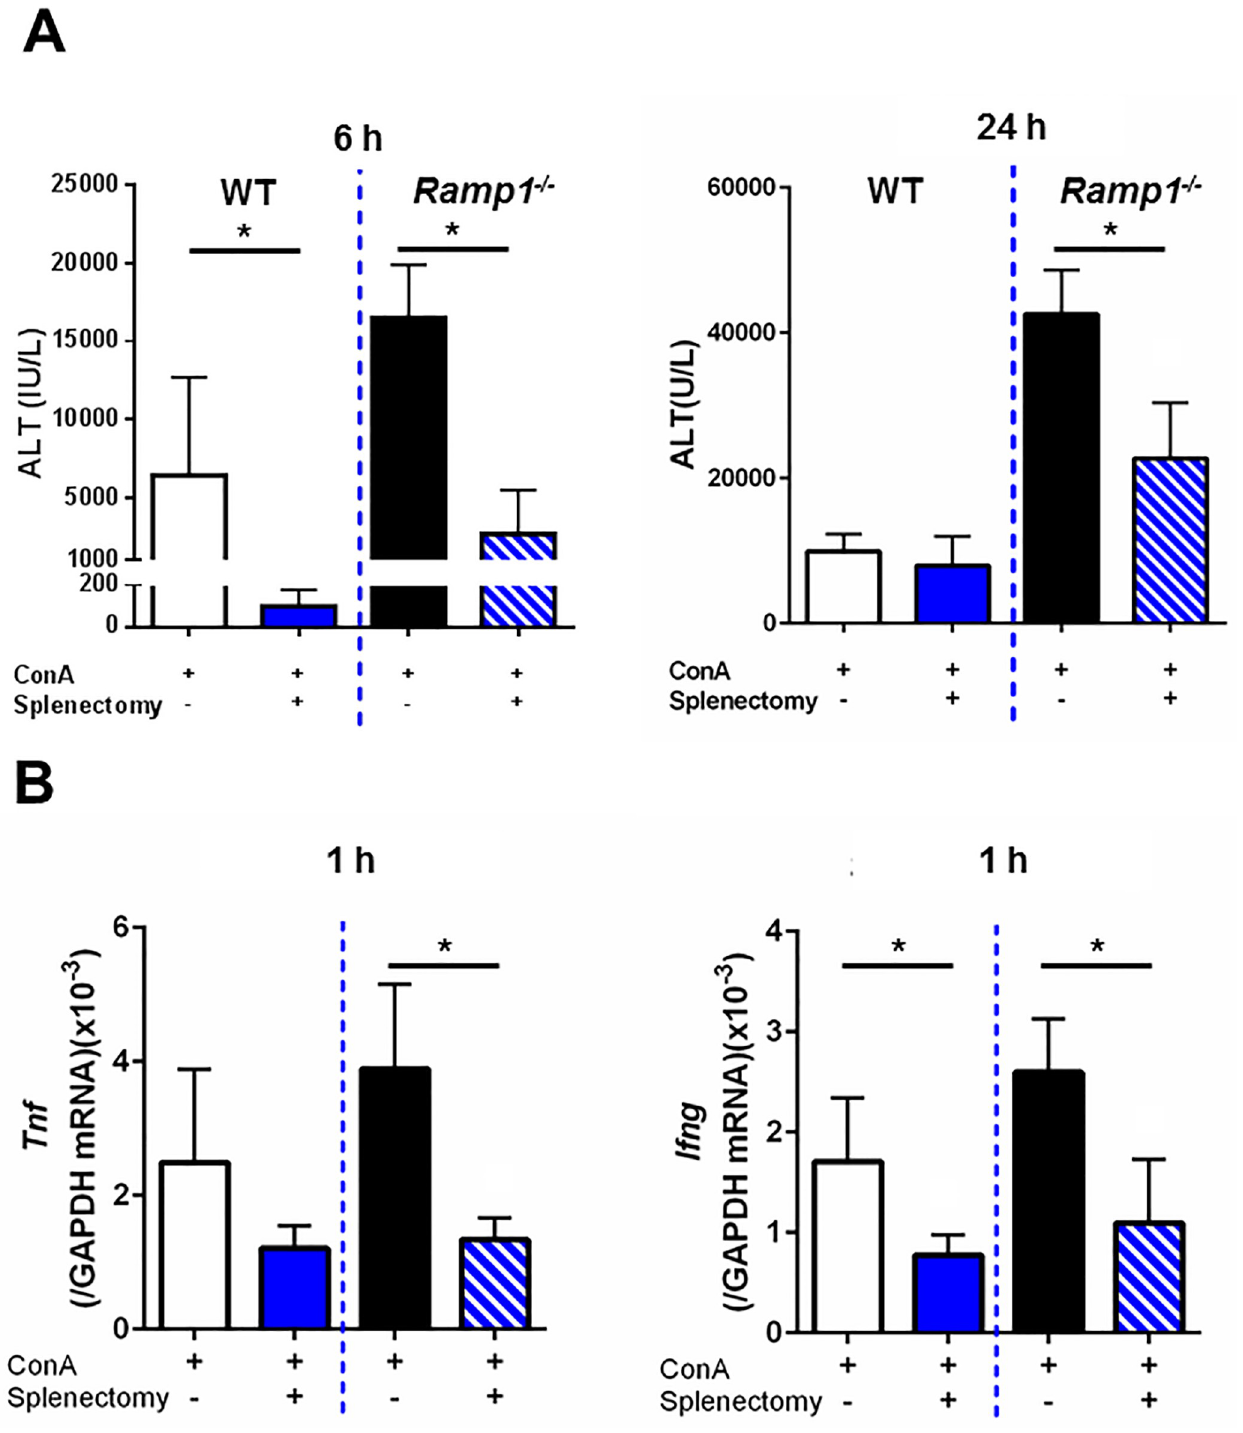
Fig 3. Effects of splenectomy on ALT and pro-inflammatory cytokines levels in mice with ConA hepatitis. (A) Splenectomy reduced ALT levels in WT and Ramp1 -/- mice at 6 h (left) and 24 h (right) after ConA treatment. ConA was administered immediately after splenectomy. Data are expressed as the mean ± SD from 4–6 mice per group. � p < 0.05. (B) Effect of splenectomy on Tnf and Ifng mRNA levels in liver from WT and Ramp1 -/- mice at 1 h after ConA administration. ConA was administered immediately after splenectomy. Data are expressed as the mean ± SD from 4–6 mice per group. � p < 0.05.